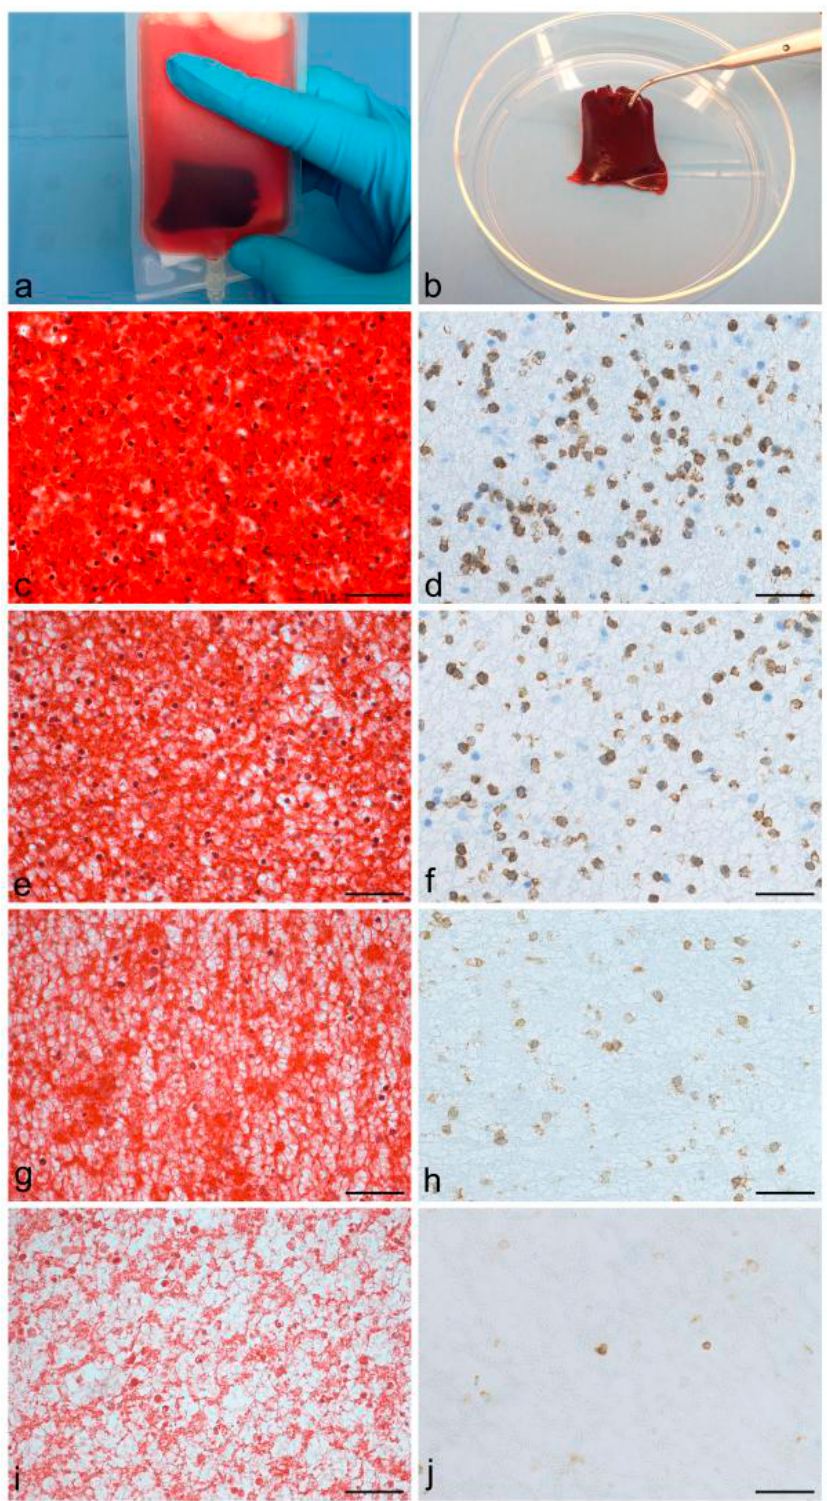
Figure 2. Macroscopic aspect of the leucocyte- and platelet-rich fibrin membrane (CLP-MB) soon after manufacture ( a , b ). Biebrich scarlet buffer-fuchsine acid staining ( c , e , g , i ) and immunological localization of CD3-positive cellular elements ( d , f , h , j ) on the CLP-MB after 4 ( c – d ), 7 ( e – f ), 14 ( g – h ) and 21 ( i – j ) days of PBS incubation at 37 °C. It is possible to recognize a progressive reabsorption of the fibrin matrix and loss of the cellular elements ( c , e , g , i ), as well as the reduction of lymphocytes ( d , f , h , j ). Scale bar: 37.5 µm.